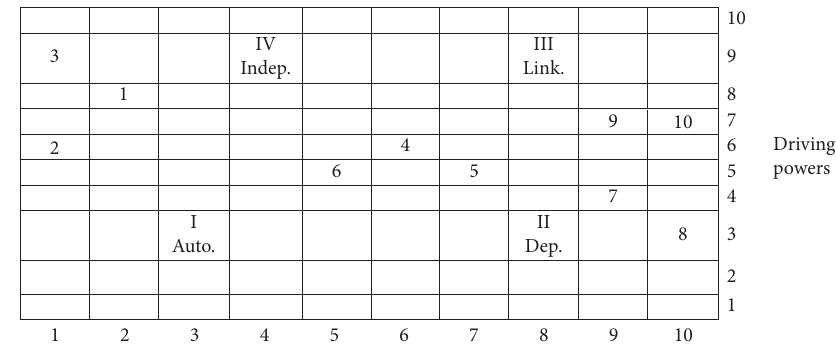
Figure 4: MICMAC analysis of ISM